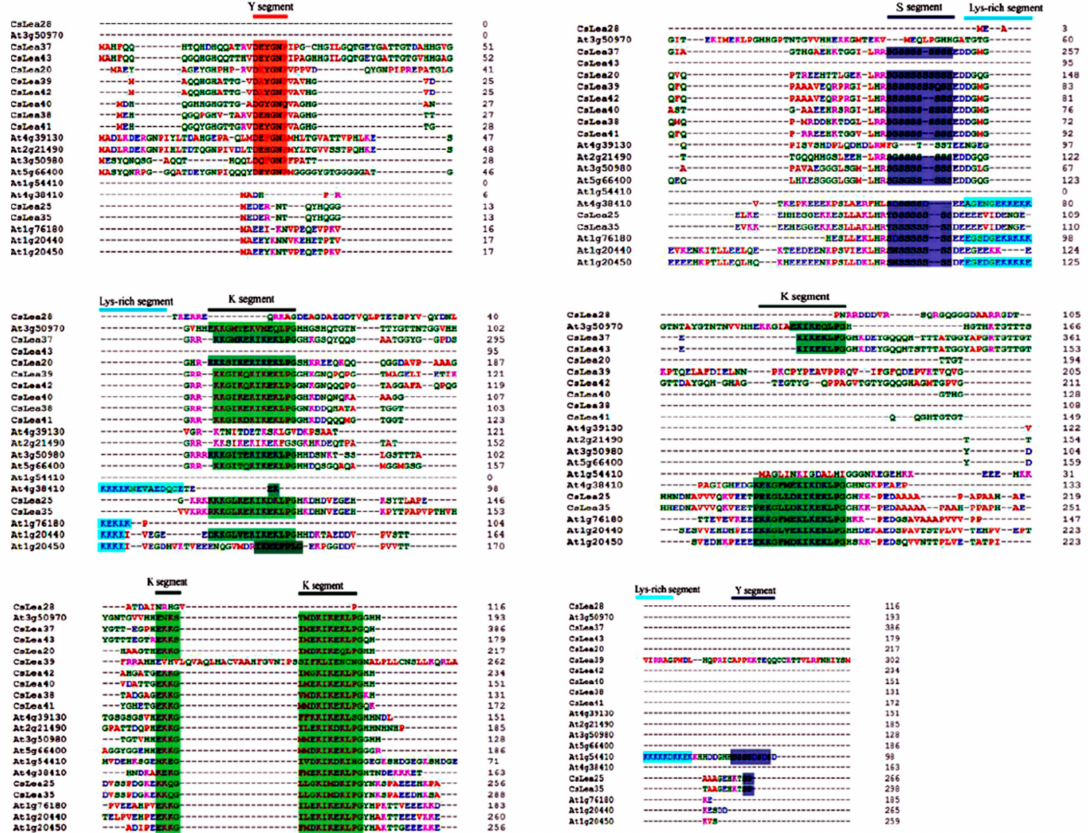
Figure 3. Multiple sequence alignment using C. songorica and Arabidopsis Dehydrin protein sequences. The identified Y segment, K segment and S segment are indicated by different colors. Y segment = red, K segment = green and S segment =